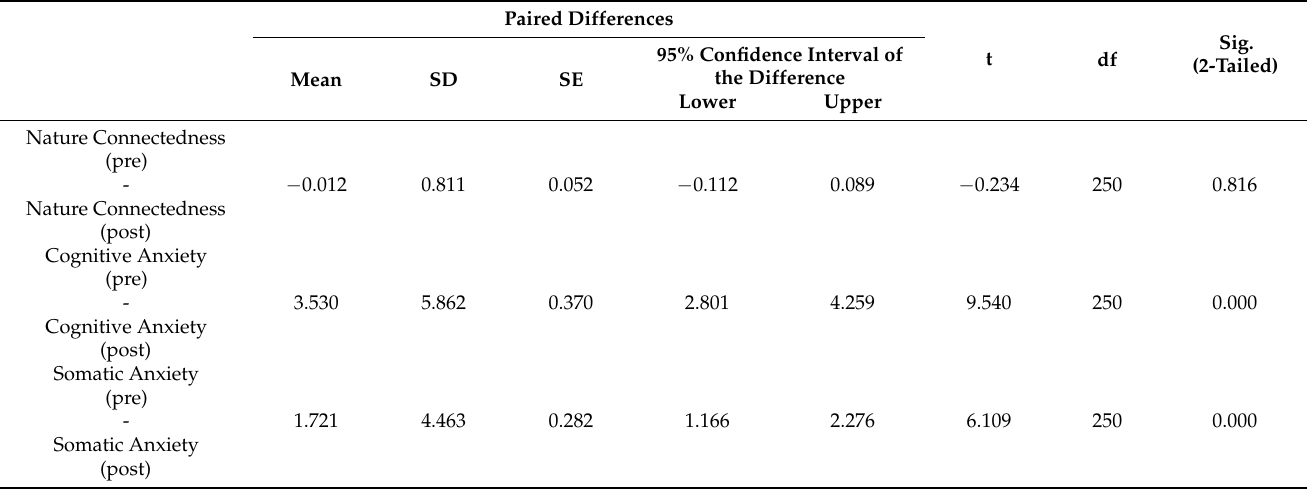
Table 4. Paired sample t -test results.